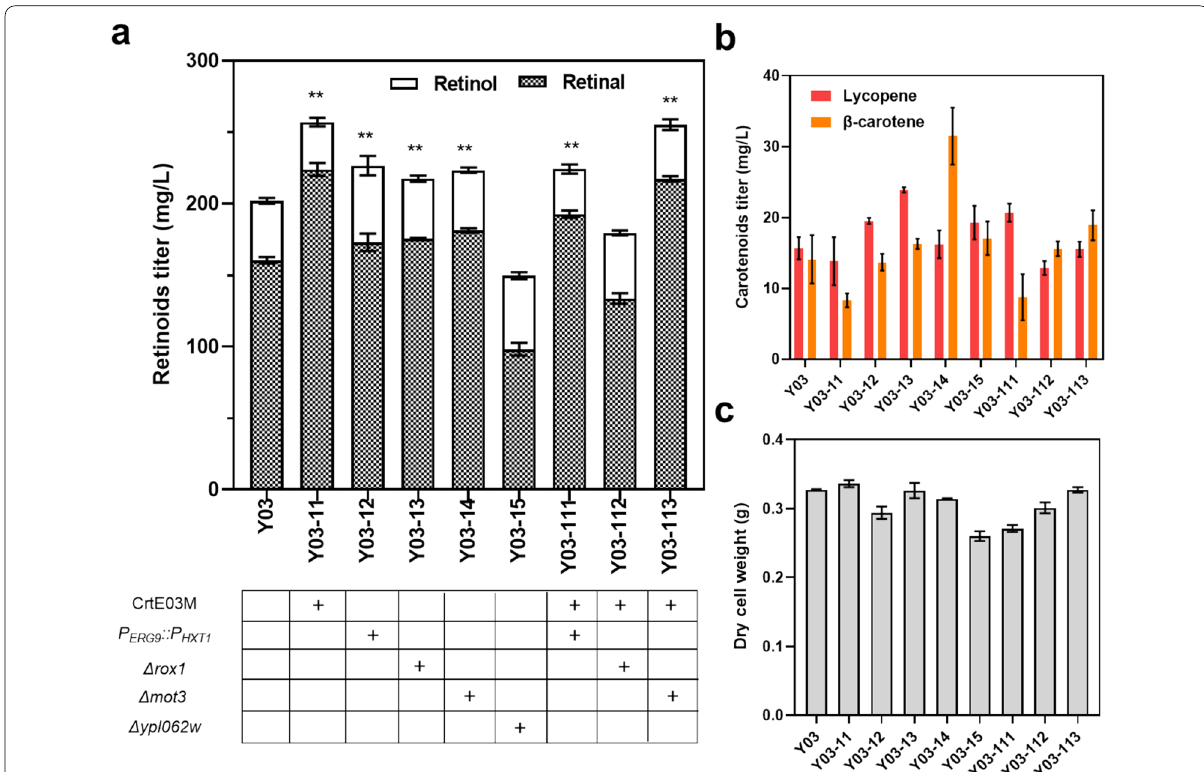
Fig. 3 Effect of CrtE03M overexpression, ERG9 downregulation, and deletion of ROX1, MOT3 or YPL062W on retinoids titer ( a ), carotenoids titer ( b ), and dry cell weight ( c ). The error bars represent standard deviations calculated from triplicate experiments, and statistical significance of the different retinoids levels in comparison with the control was evaluated using Student’s t test (*, P < 0.05; **, P <